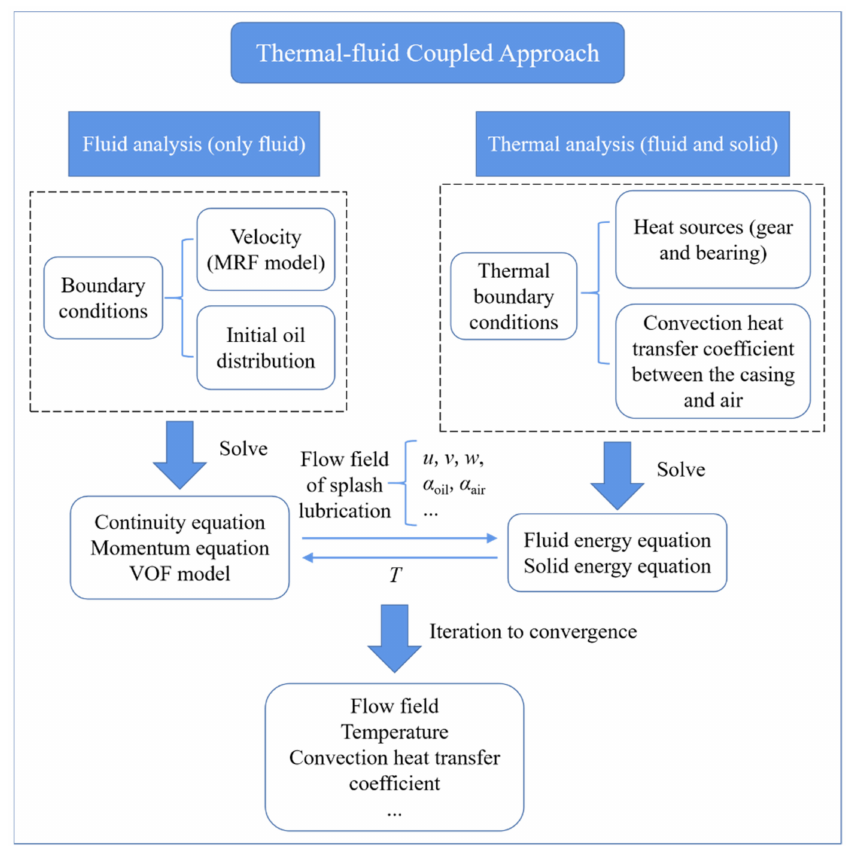
Figure 9. Flow chart of the coupled thermal-fluid approach. (MRF model refers to multiple reference frames (MRF) model, and VOF model refers to volume of fluid (VOF) multiphase